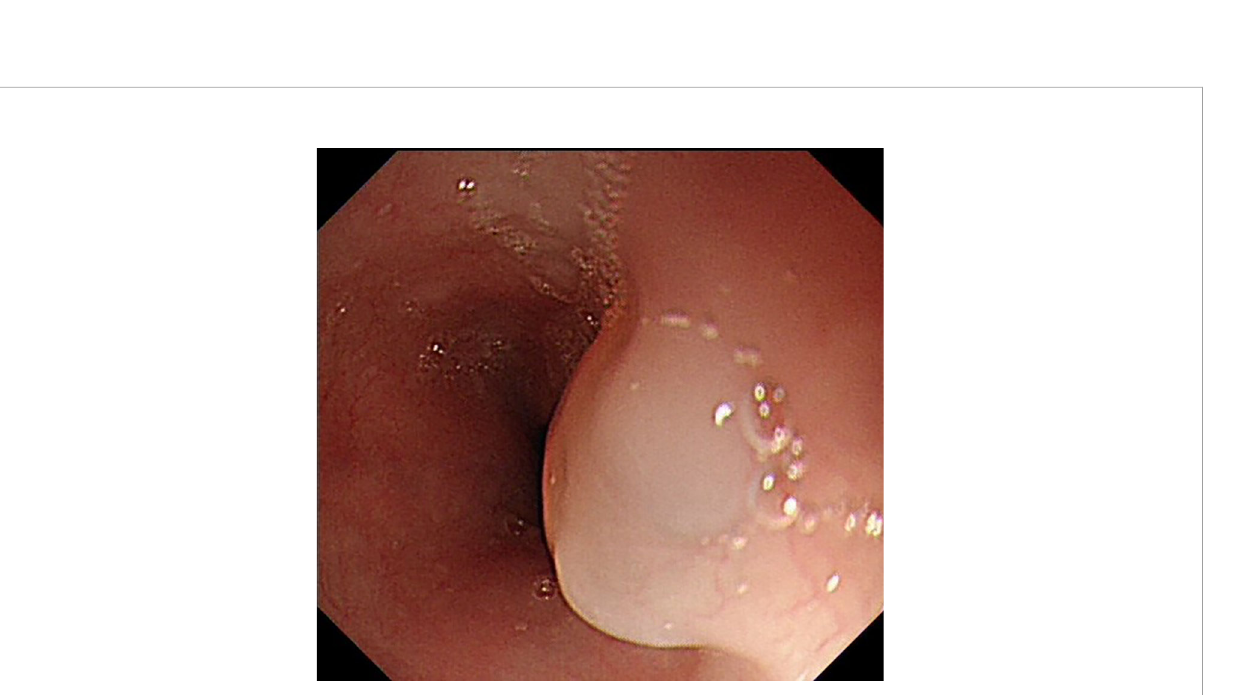
FIGURE 2 Endoscopic appearance of lymphangioma in the